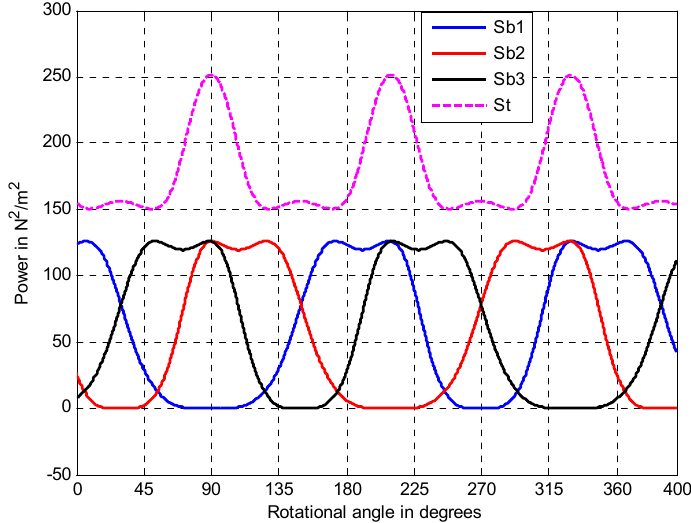
Figure 18. Power produced by the blades as a function of the rotational angle.